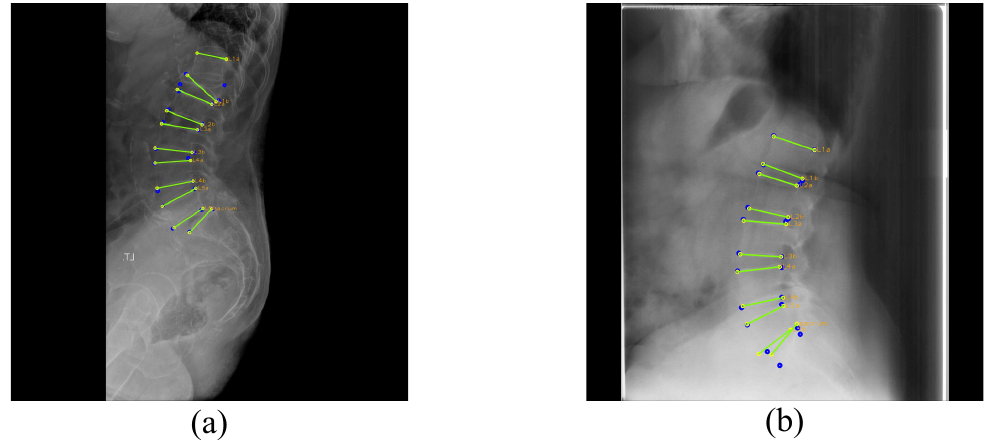
Figure 17. Landmark detection failure cases. ( a , b ) are outlier cases caused by severe compression fracture and occlusion, respectively. The blue circles represent the ground truth, while yellow circles with labels represent predicted results, and the green lines represent the line connecting the predicted landmarks of an